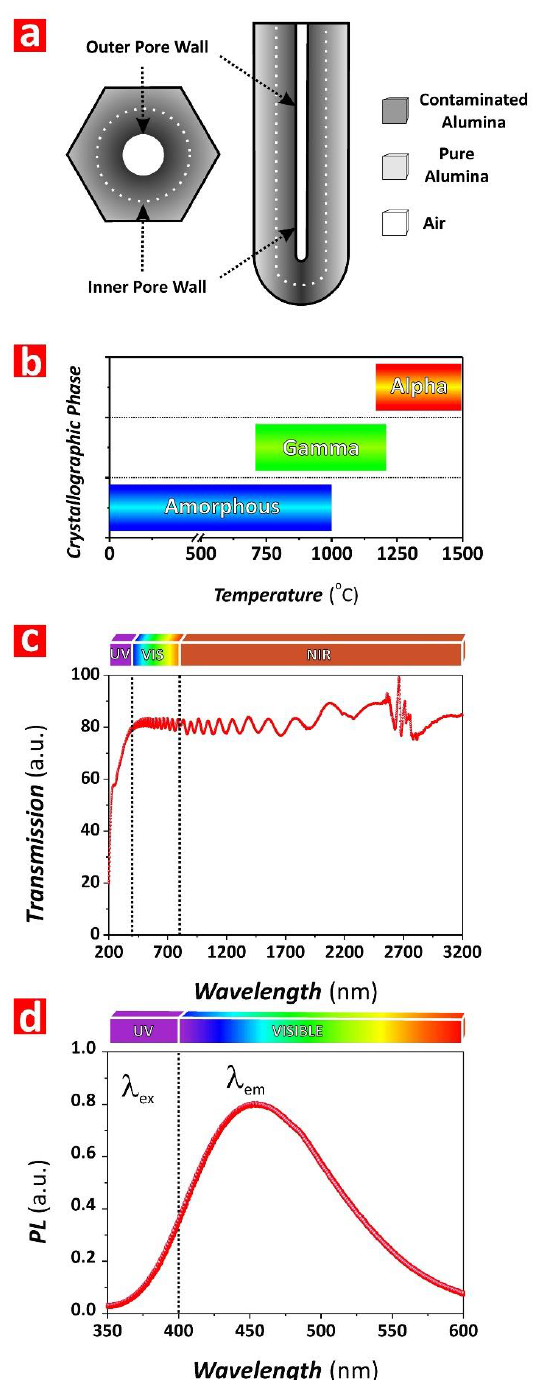
Figure 4. Physical properties of nanoporous anodic alumina (NAA). ( a ) Onion-like chemical structure of NAA with impurities distribution around the central nanopore. ( b ) Crystallographic phases of NAA as a function of temperature. ( c ) Representative UV-visible-near-infrared (NIR) transmission spectrum of NAA (note: NAA produced by two-step anodization under MA regime in oxalic acid electrolyte). ( d ) Representative photoluminescence spectrum of NAA (note: NAA produced by two-step anodization under MA regime in oxalic acid electrolyte).